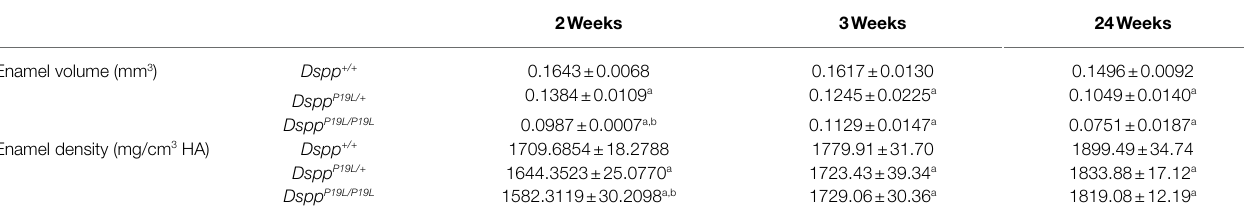
TABLE 2 | Micro-Computed Tomography analysis of mandibular first molar enamel.